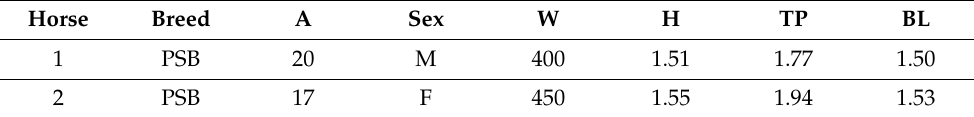
Table 1. Characteristics of the therapy horses of this study. Horse